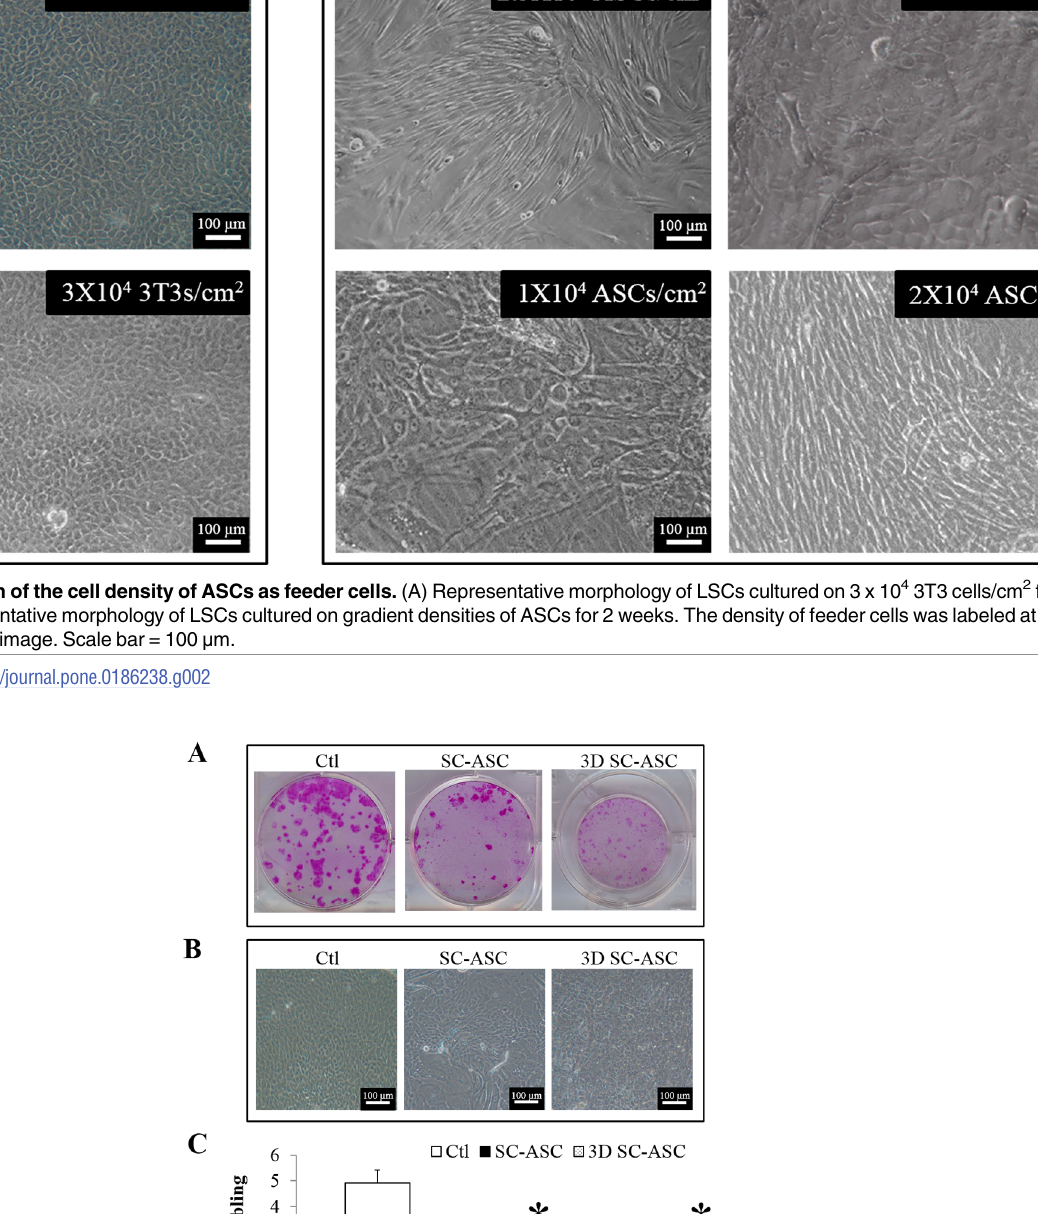
PLOS ONE | https://doi.org/10.1371/journal.pone.0186238 October 11,